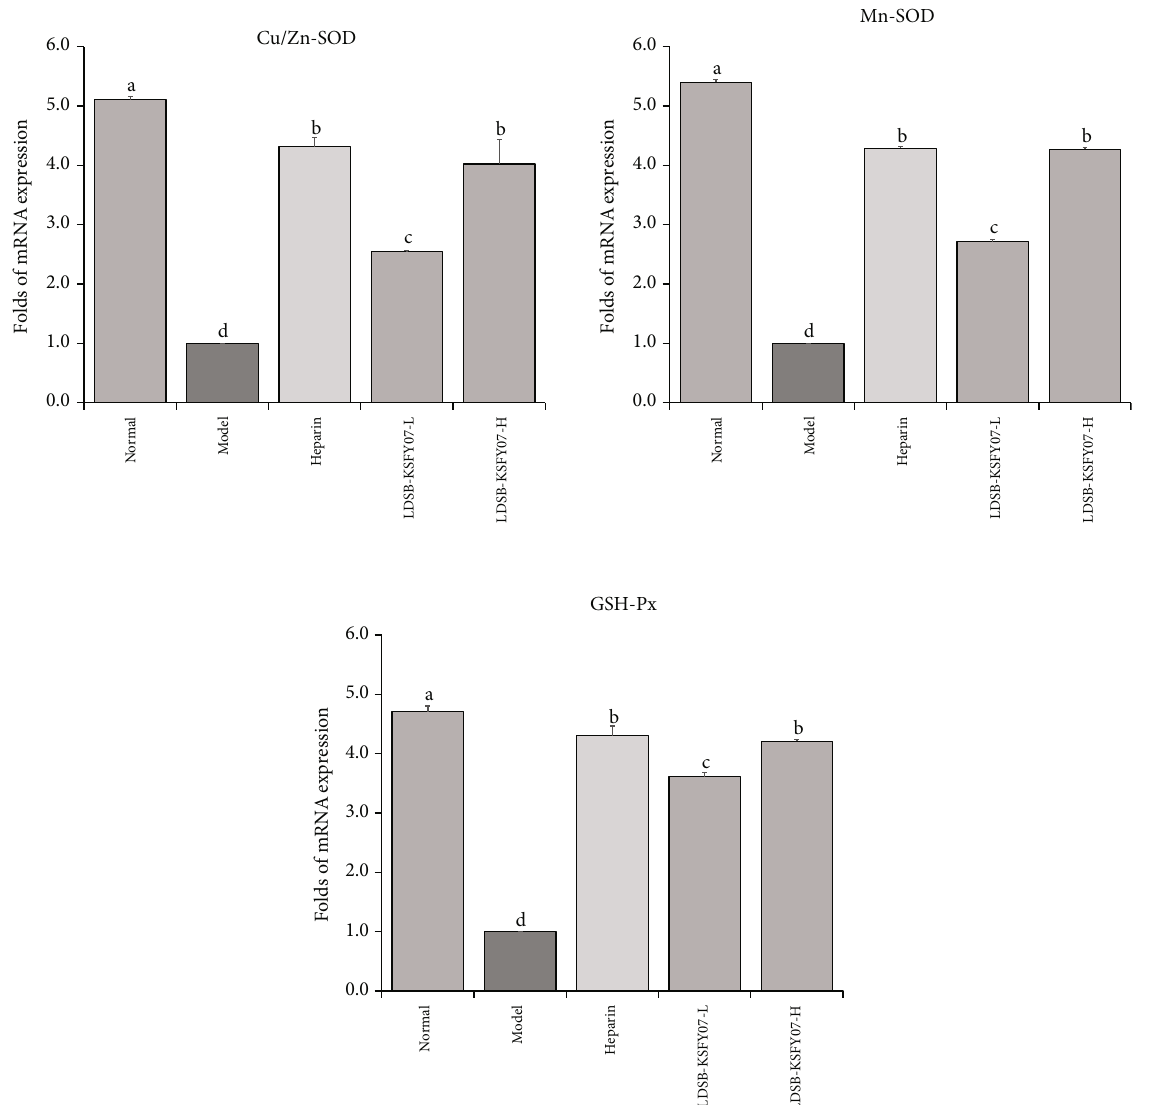
Figure 3: Cu/Zn-SOD, Mn-SOD, GSH-Px, and MDA mRNA expressions in liver tissue of mice with kappa-carrageenan-induced thrombosis. The results have been expressed as mean ± deviation . (A – D) Mean values with di ff erent bars in the di ff erent column are signi fi cantly di ff erent ( P < 0 : 05 ) according to Duncan ’ s multiple range